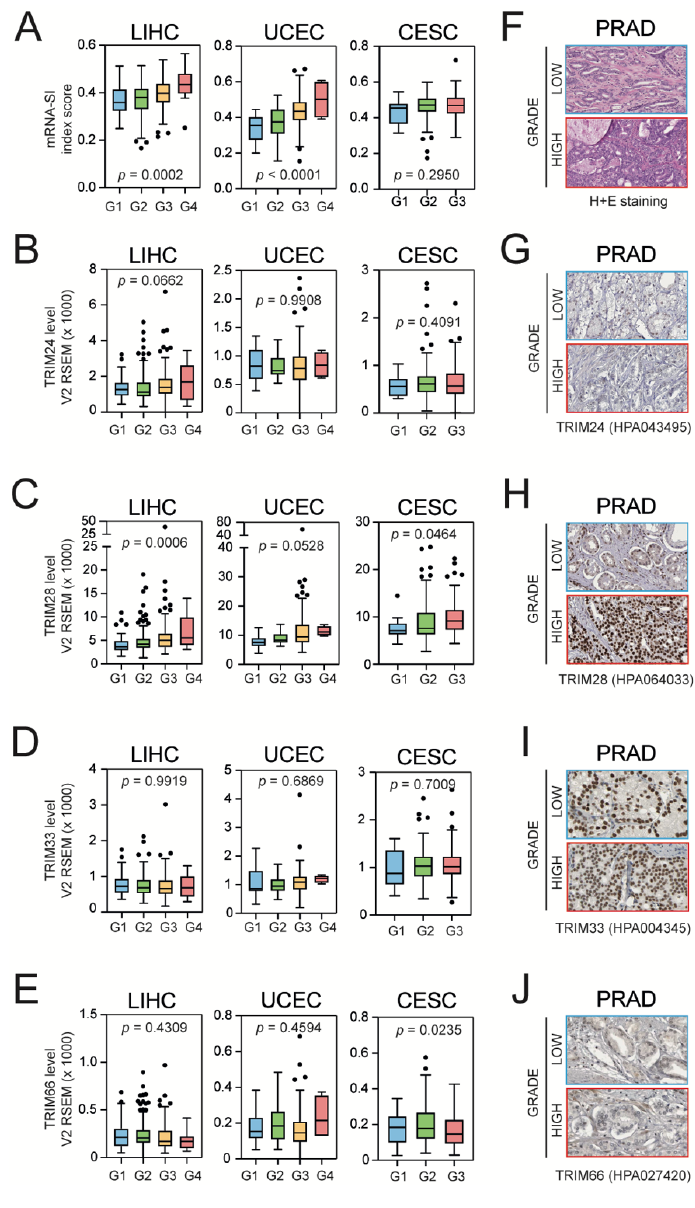
Figure 3. The level of mRNA-SI and TIF1 expression in lower and higher grade tumors. ( A ) Higher grade tumors exhibit higher mRNA-SI values as presented for LIHC (left panel), UCEC (middle panel), and CESC (right panel). G1–G4—grade 1–4 (the “neoplasm histologic grade” feature from TCGA data). ( B – E ) Among the other TIF1 family members, the expression of TRIM28 is significantly elevated in higher grade tumors. ( F ) Hematoxylin–eosin staining of lower and higher grade PRAD tumors. ( G – J ) Representative immunohistochemistry staining for TRIM24 ( G ), TRIM28 ( H ), TRIM33 ( I ), and TRIM66 ( J ) of lower and higher grade PRAD tumors (from www.proteinatlas.org, accessed on 10 August